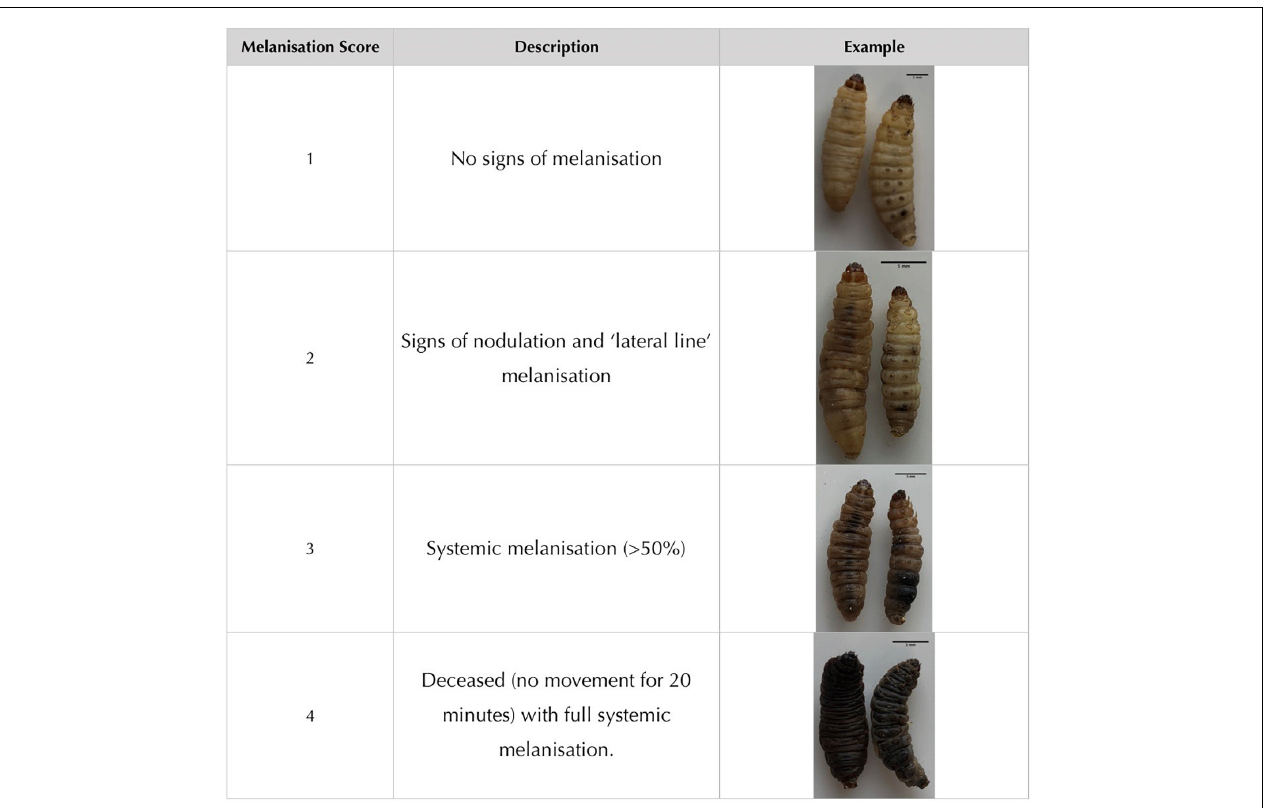
FIGURE 1 | Melanisation scoring system adapted from Senior et al. (2011).